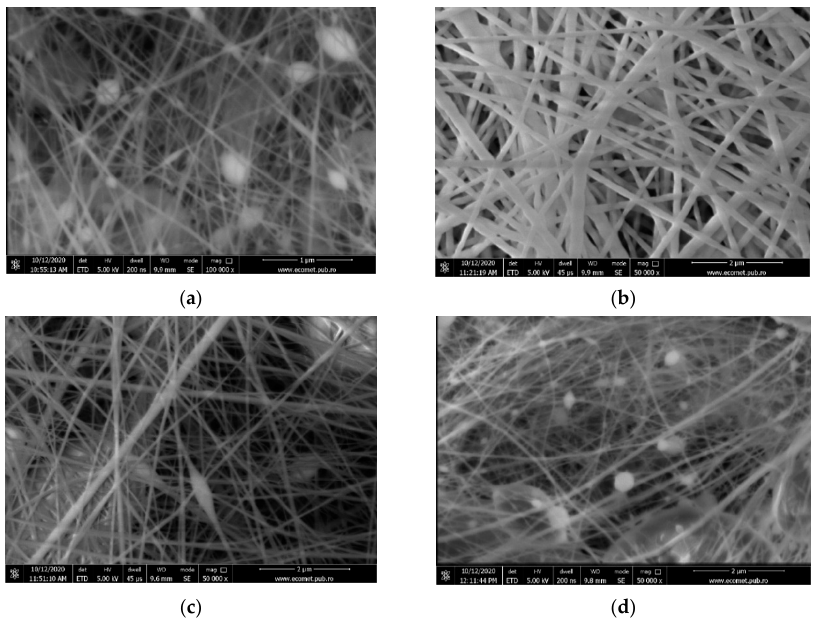
Figure 1. Scanning electron microscopy (SEM) images for: Col—collagen glue nanofibers ( a ) , Col/ZnO nanoparticles (NPs) ( b ) , Col/TiO 2 -N-silver nanoparticles (AgNPs) ( c ) , and Col/chitosan (CS) ( d ).